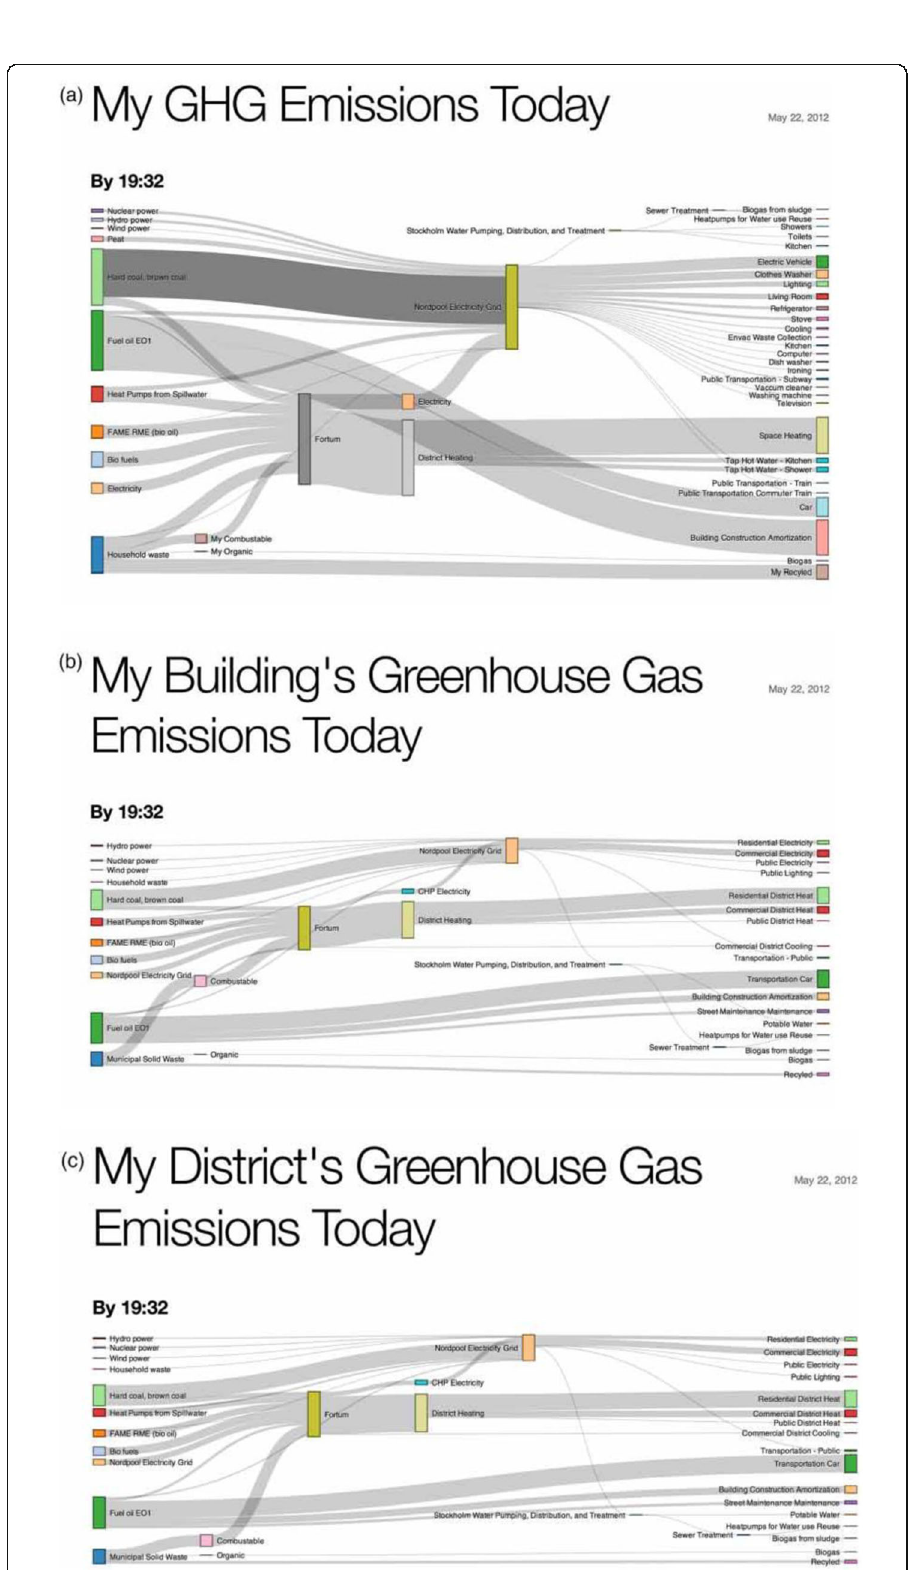
Fig. 2 a Visualization of a household carbon metabolism, b visualization of a building carbon metabolism, and c visualization of the district ’ s carbon metabolism, all at a given time through the use of Sankey diagrams. Source: Shahrokni et al.